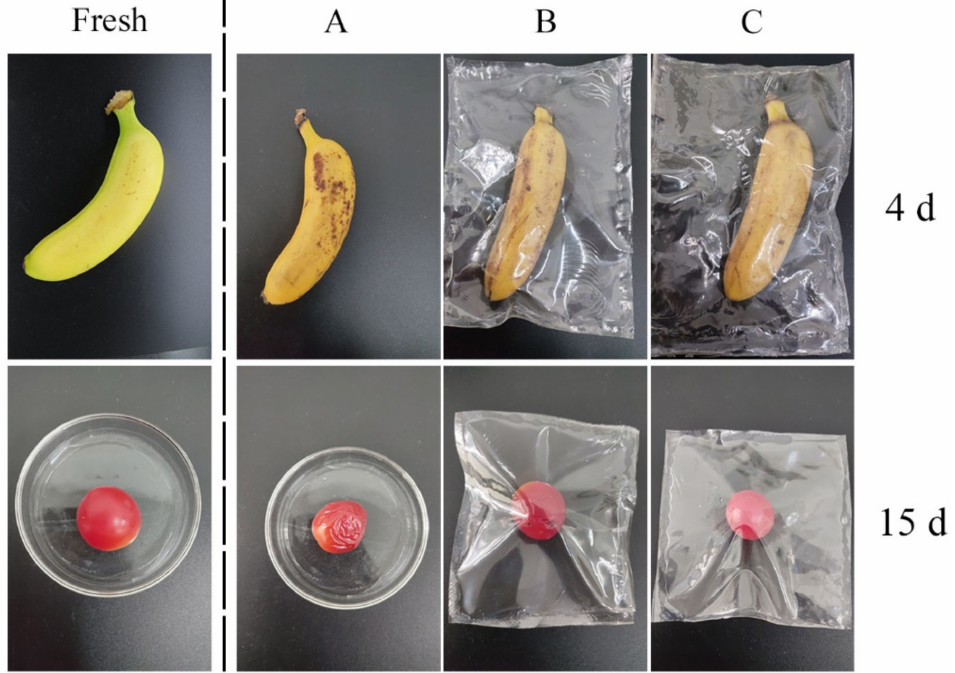
Figure 14. Assay of CA-loaded composite nanoparticles application in bananas and cherry tomatoes (left, fresh bananas and cherry tomatoes; ( A ) storage in air; ( B ) wrapped in PVA film; ( C ) wrapped in PVA film containing 0.25 wt% CA-loaded composite